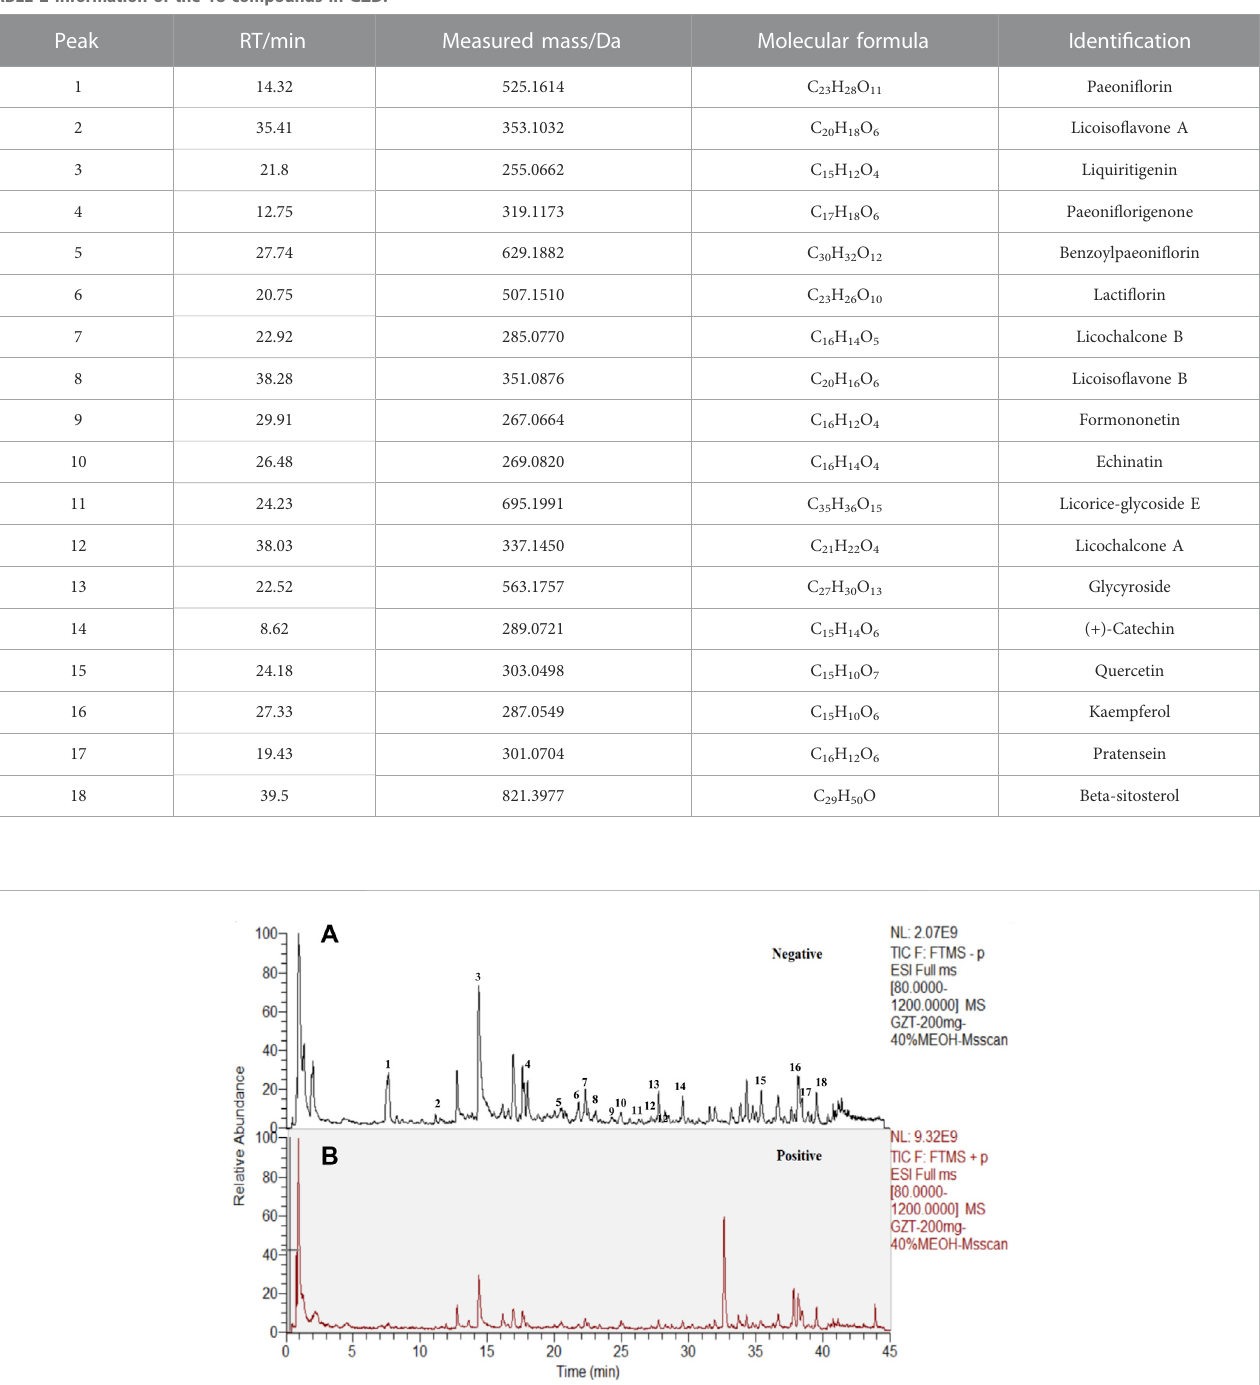
TABLE 2 Information of the 18 compounds in GZD.